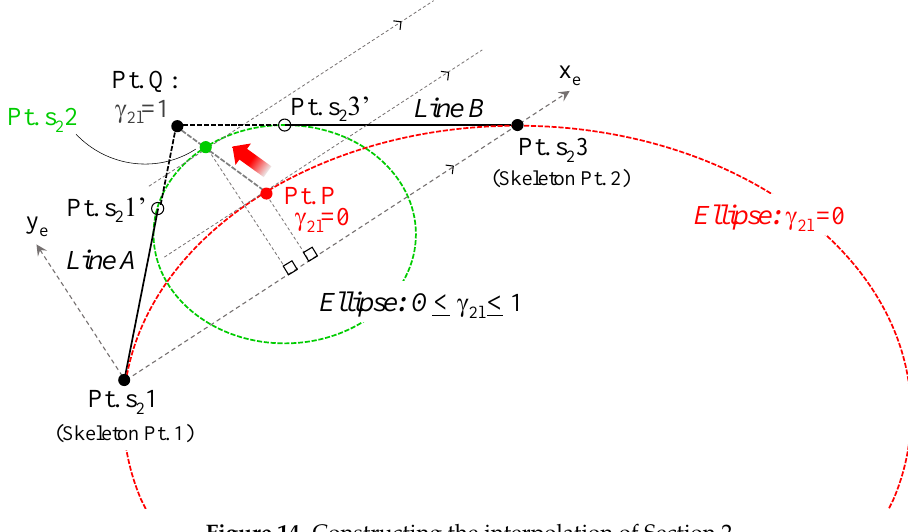
Figure 14. Constructing the interpolation of Section